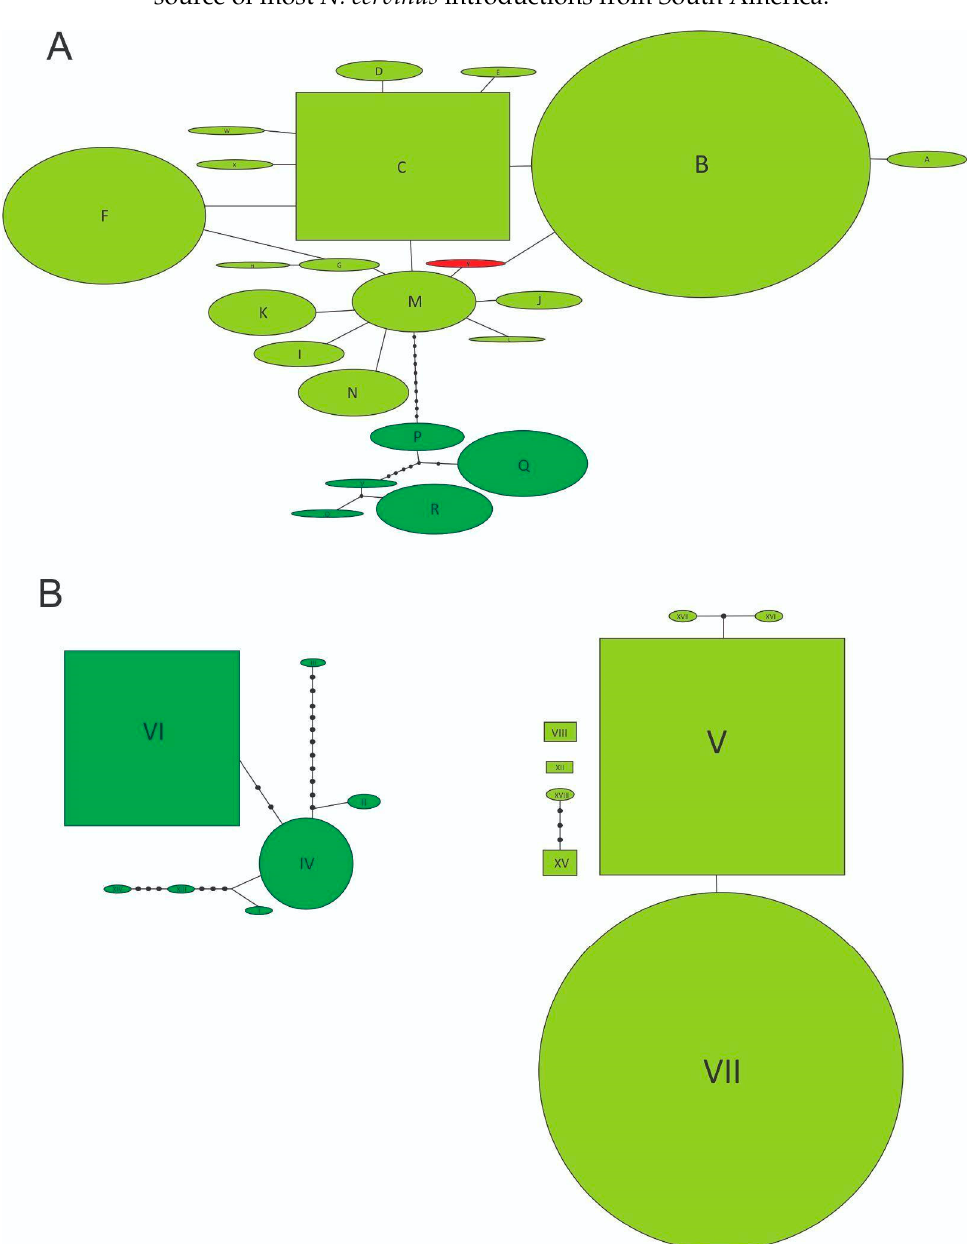
Figure 2. ( A ) Statistical parsimony network of mitochondrial haplotypes. Lines represent the most-parsimonious relationships between haplotypes and indicate one mutational step between two hap- lotypes. Dark green open circles represent individual haplotypes from the Forest Clade, light green open circles represent individual haplotypes from the Grassland Clade, red open circle represents the novel Y haplotype, and unlabeled black circles indicate inferred intermediate haplotypes not found in the samples. Rectangles indicate possible ancestral haplotypes. Circle size is proportional to haplotype frequency. ( B ) Statistical parsimony network of nuclear alleles and the graphical rep- resentation follows nomenclature explained in Figure 2A. Individual haplotype and allele codes follow Table 1A.